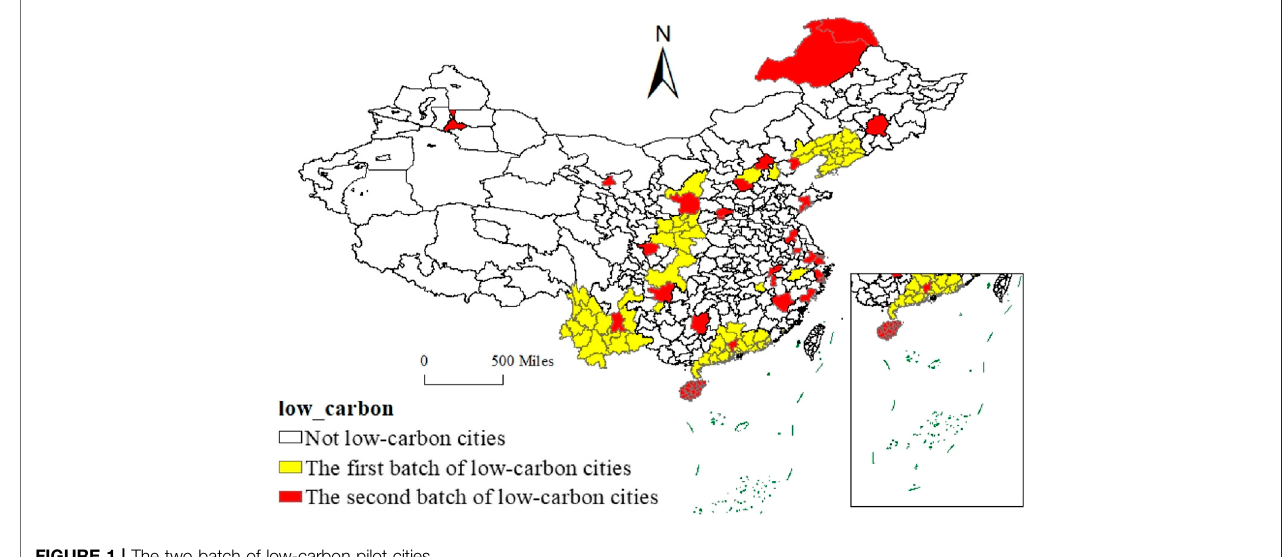
FIGURE 1 | The two batch of low-carbon pilot cities.